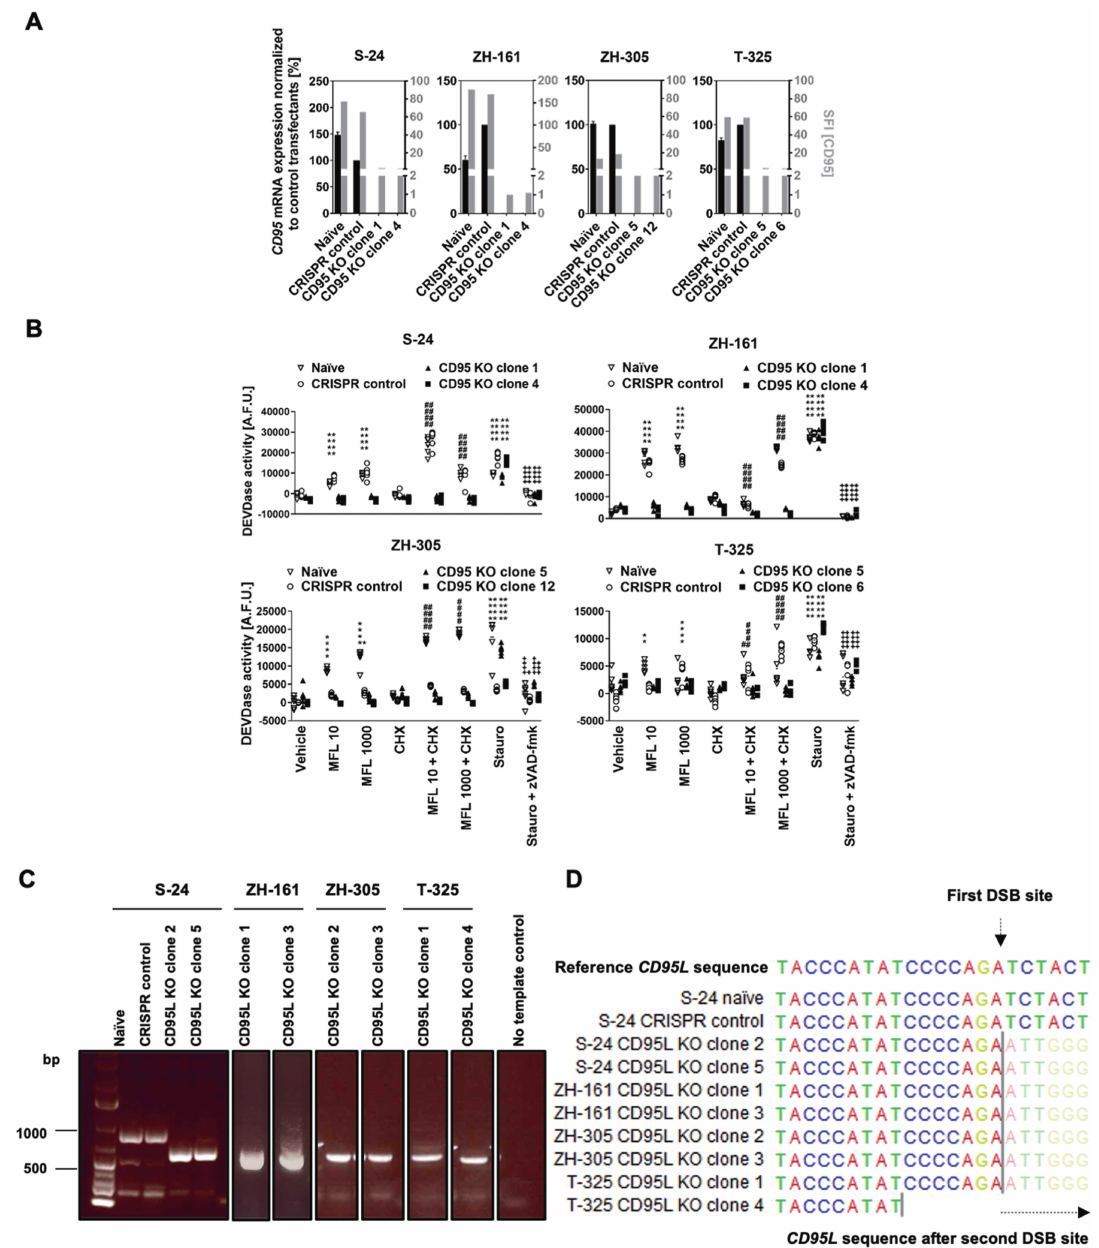
Fig. 3 CD95 and CD95L CRISPR knockout (KO) in selected human GIC. The CD95 or CD95L genes were depleted via CRISPR-Cas9 in S-24, ZH- 161, ZH-305, or T-325 cells. A CD95 clonal knockout sublines were assessed for expression of the CD95 transcript spanning the two predicted double-strand DNA break (DSB) sites by RT-qPCR using ARF1 as internal control and of cell surface protein by fl ow cytometry. RT-qPCR data are expressed as mean and SD. Speci fi c fl uorescence indexes (SFI) were calculated by dividing the median fl uorescence intensities of the experimental antibody and the isotype control. B CD95 KO was functionally validated by assessing the sensitivity of naïve, CRISPR control or CD95 KO S-24, ZH-161, ZH-305, or T-325 cells to exogenous CD95L-mediated apoptosis. Naïve, CRISPR control or CD95 KO S-24, ZH-161, ZH- 305, or T-325 cells were stimulated with 10 or 1000 ng/ml exogenous CD95L (Mega-Fas-Ligand, MFL) in the absence or presence of cycloheximide (CHX) (10 µg/ml) for 6 h and assessed for caspase 3/7-like Ac-DEVD-amc-cleaving activity (DEVDase activity). As a positive control, cells were treated with 1 μ M staurosporine (stauro). As a negative control, cells were treated with the pan-caspase inhibitor zVAD-fmk (10 μ M) in combination with staurosporine. A representative experiment is shown for each cell line. Data of six technical replicates (triangles) are shown. Statistical signi fi cances were calculated by two-way ANOVA followed by Bonferroni ’ s post hoc test (* p < 0.05, ** p < 0.01, **** p < 0.0001 versus vehicle; #### p < 0.0001 versus CHX; + p < 0.05, +++ p < 0.001, ++++ p < 0.0001 versus stauro). C , D CD95L clonal knockout sublines were selected based on the absence of the CD95L genomic DNA sequence spanning the two predicted DSB sites. The CD95L gene fragment spanning the two predicted DSB sites was ampli fi ed by PCR using primers fl anking the single guide RNA (sgRNA) target sequences and amplicon size was veri fi ed by agarose gel electrophoresis ( C ). Amplicon sequence was elucidated by Sanger sequencing with primers targeting the upstream sequence of the fi rst sgRNA target sequence ( D ). Naïve refers to non-transfected cells, while CRISPR control refers to cells transfected with non-targeting sgRNA in pSpCas9(BB)-2A-GFP plasmids. A.F.U., arbitrary fl uorescence units.